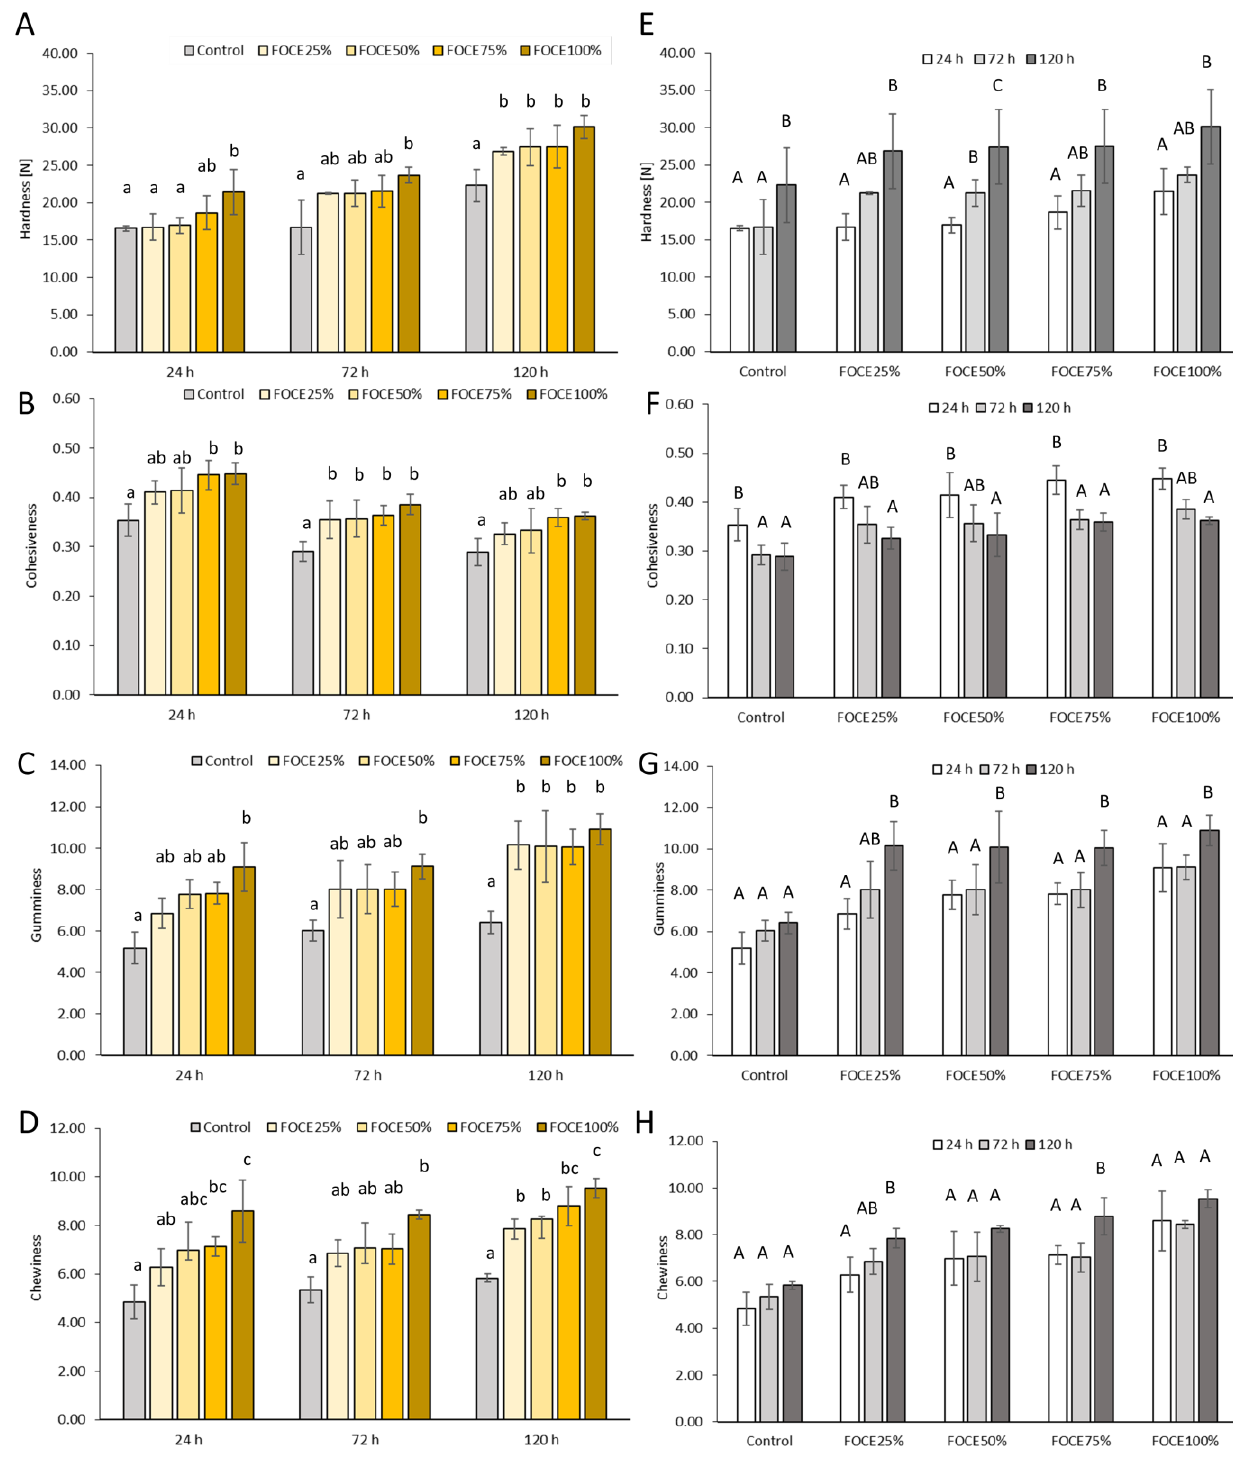
Figure 2. Changes in the hardness, cohesiveness, gumminess and chewiness of experimental GFBs related to FOCE level ( A – D ) and storage time ( E – H ). a – c different lowercase letters indicate significant differences between GFBs with different FOCE levels at the same storage time ( p < 0.05); A – C different capital letters indicate significant differences between storage times for the same bread ( p < 0.05).